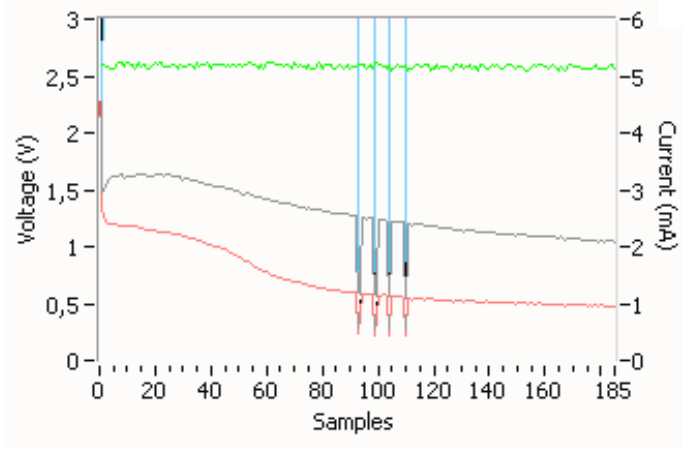
Figure 7. Supercapacitor discharge (green) for two consecutive opening and closing actions of the solenoid (in